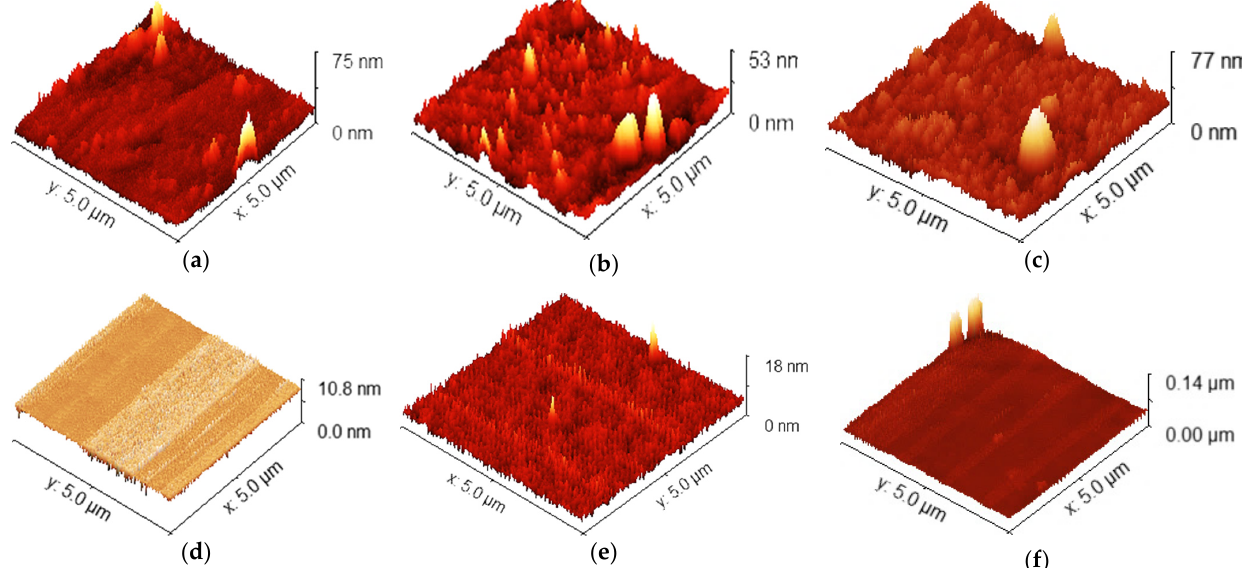
Figure 2. 3D AFM images obtained from the samples deposited on Si: S1 ( a ), S2 ( b ), S3 ( c ), S4 ( d ), S5 ( e ), and S6 ( f ).